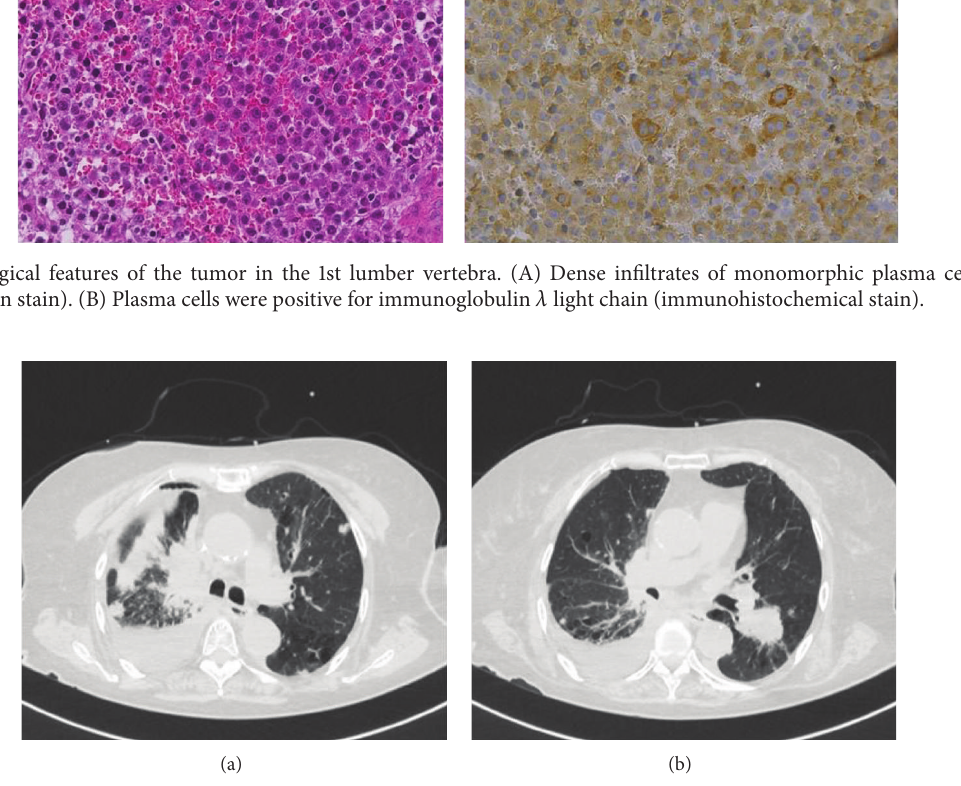
were not detected. In March 2011, she died of respiratory failure irrespective of various supportive therapies.